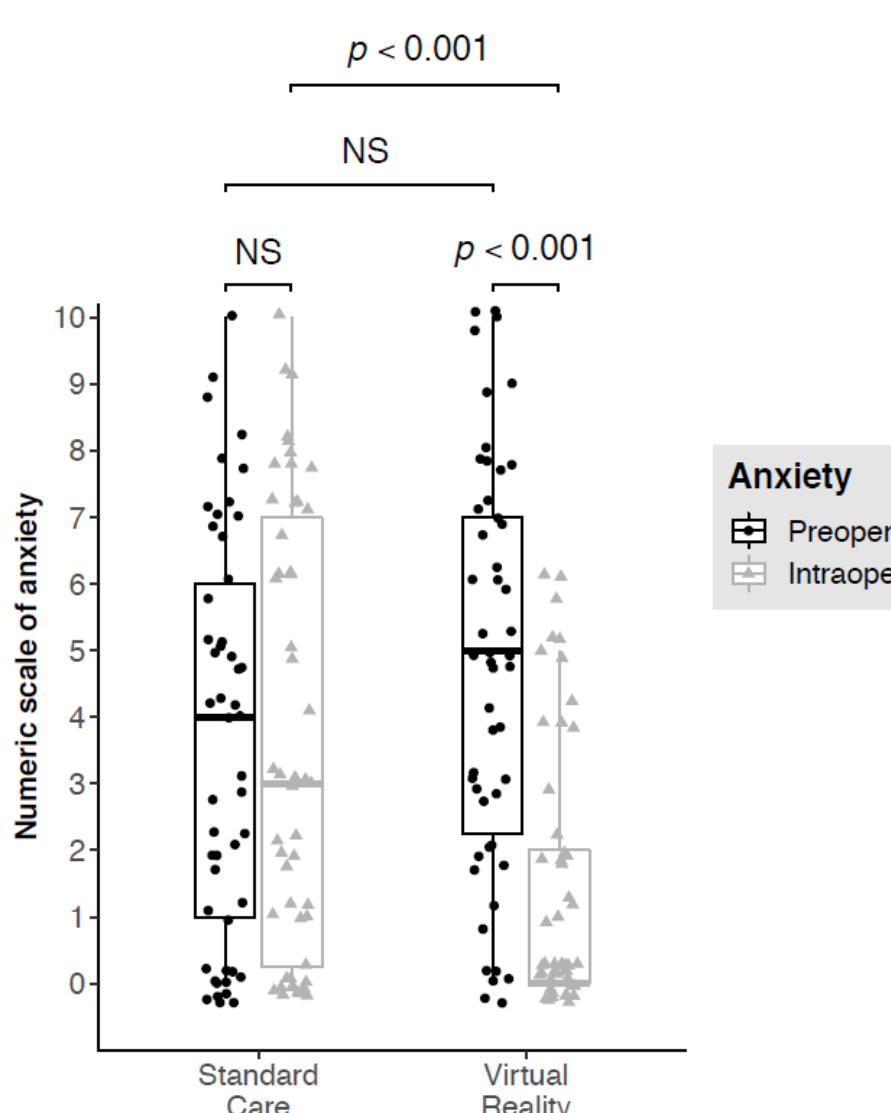
Figure 3. Boxplot graphical representation of perioperative (pre—in dark-grey plots and intraoperative—in light-grey triangles) anxiety scores of patients operated before (Standard Care group) and after (Virtual Reality group) virtual reality became available in the department. The upper edge of the box represents the 75th percentile and the lower edge represents the 25th percentile. The vertical length of the box represents the interquartile interval and the central horizontal line represents the median. The upper moustache extends from the upper edge to the highest value at 1.5 times the interquartile space. The lower moustache extends from the lower edge to the lowest value at 1.5 times the interquartile space. Each dot or triangle represents a patient. Some jittering was added to prevent the overplotting of dots.